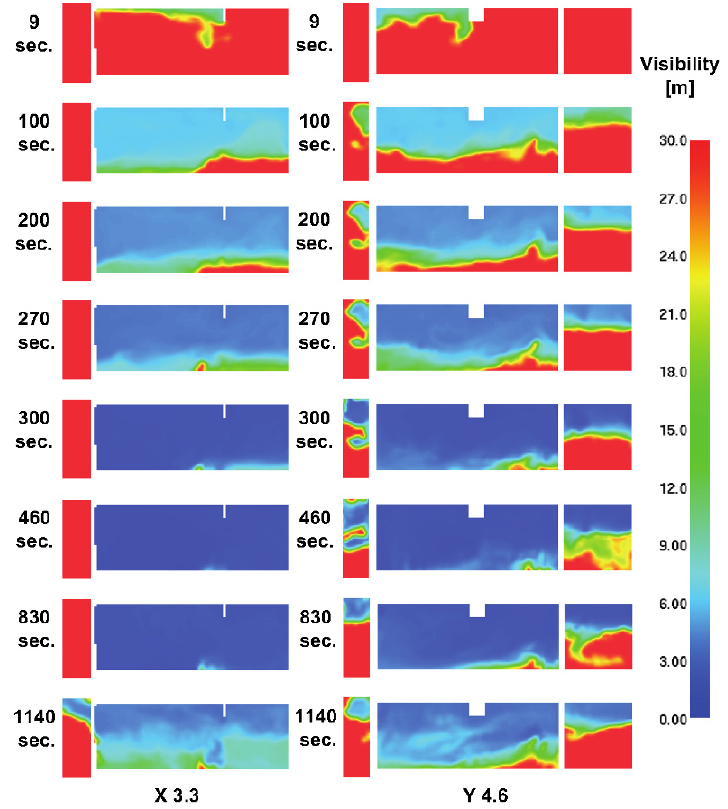
Figure 10. Visibility field on section 3.3 X - 9, 100, 200, 270, 300 and 1140 seconds.